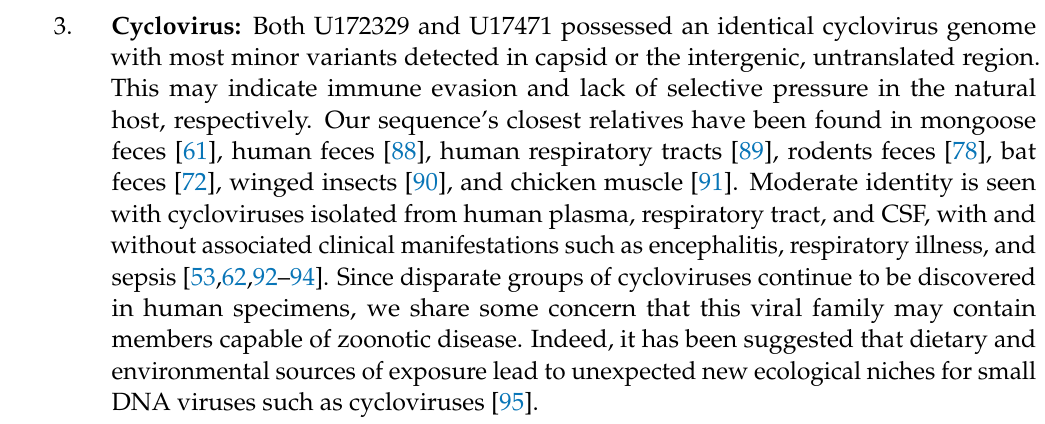
circularviruses; Figure S2: Genomic coverage statistics for the assembled Jingmanvirus; Figure S3: Genomic coverage statistics for the assembled densovirus; Figure S4: Genomic coverage statistics for the assembled nodaviruses; Figure S5: Genomic coverage statistics for the partially-assembled picor- naviruses; Figure S6: Maximum likelihood phylogenetic reconstruction of the ORF1 protein sequence of the dicistroviruses and the Rep protein sequence of cycloviruses; Table S1: List of accessions and metadata referring for the reference sequences from the phylum Pisuviricota utilized as a training set for the linear discriminant analysis shared in the Main Text, Figure